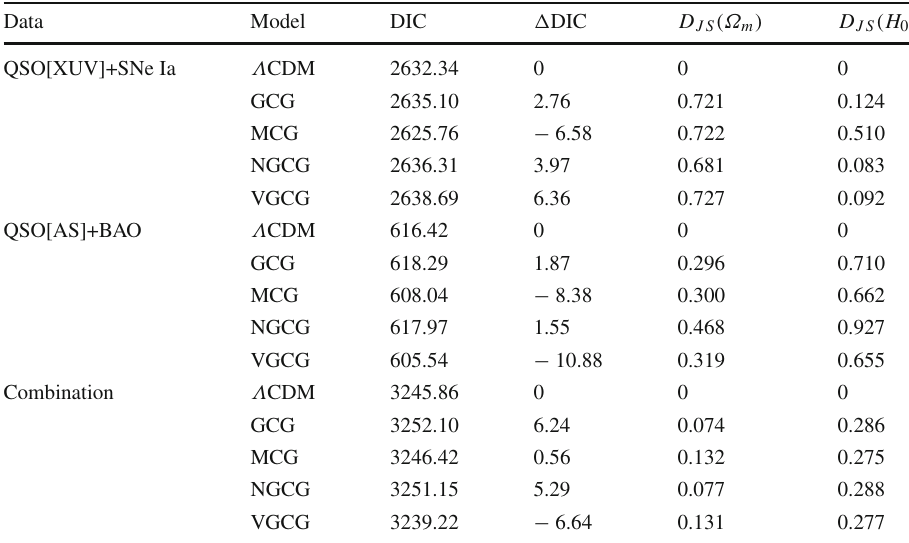
Table 3 The values of DIC and their differences for CG and Λ CDM cosmologies.